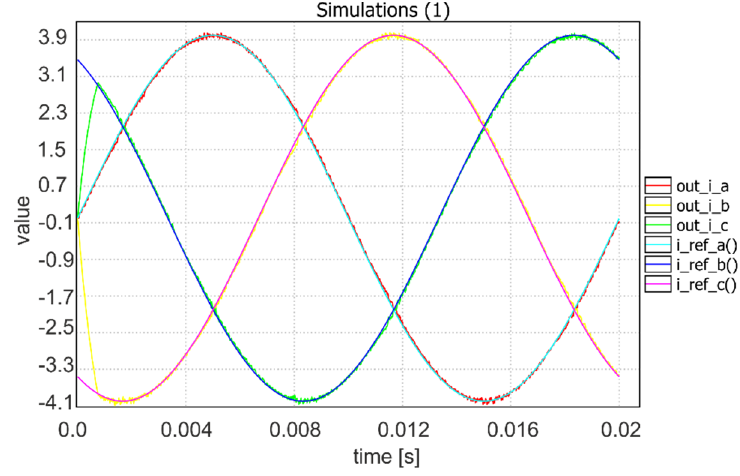
Figure 10. Simulation of a power electronics converter system using UPPAAL. Table 2. Sample queries for estimation of the probability (Pr) of reaching a certain controller